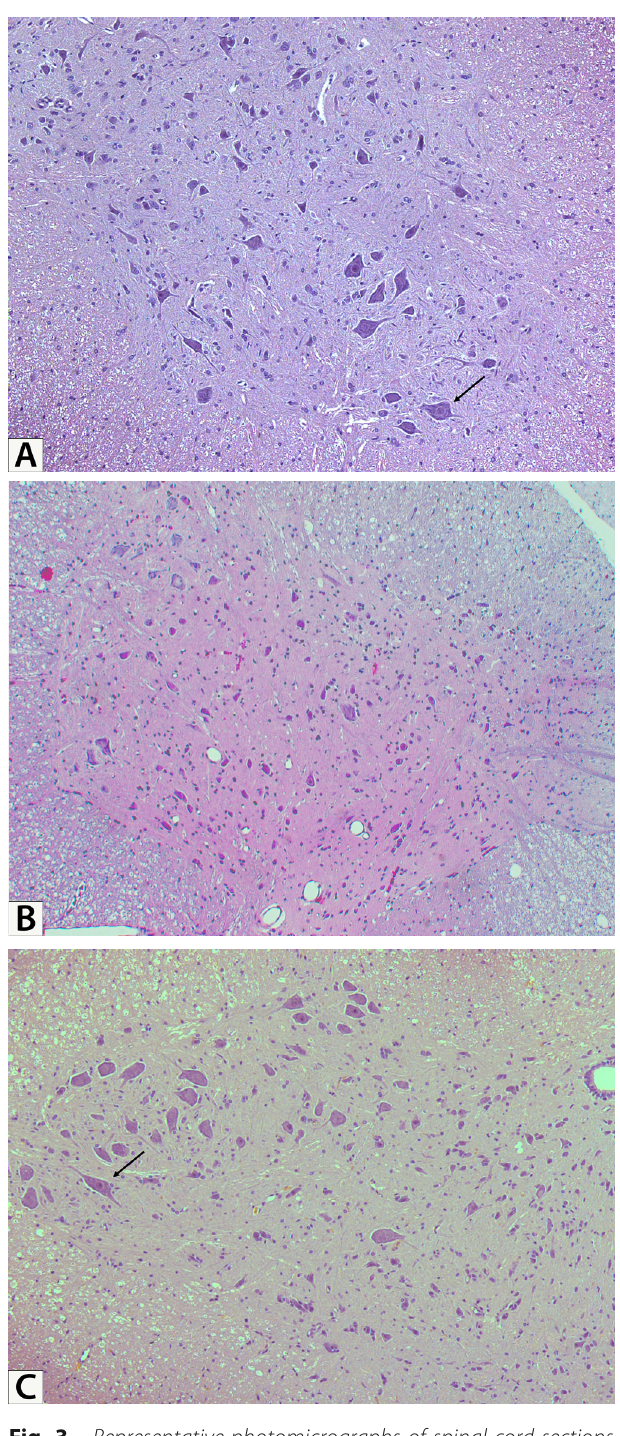
Fig. 3 - Representative photomicrographs of spinal cord sections in each group (stained with hematoxylin and eosin, ×200 magnification). A) The sham group, demonstrating motor neurons with normal histologic features (arrow). B) The control group, indicating injured motor neurons with marked vacuolization and shrunken cellular bodies. No motor neuron with normal histologic features is depicted. C) The Rd group, exhibiting relatively well- preserved normal motor neurons